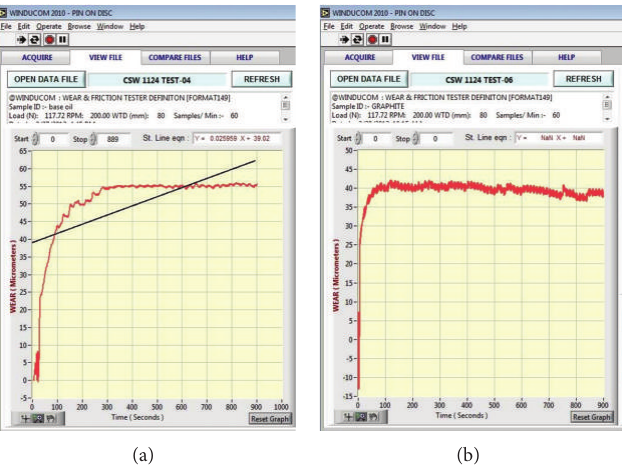
Figure 9: Wear in (a) mineral oil and (b) mineral oil + 0.5% wt graphite.